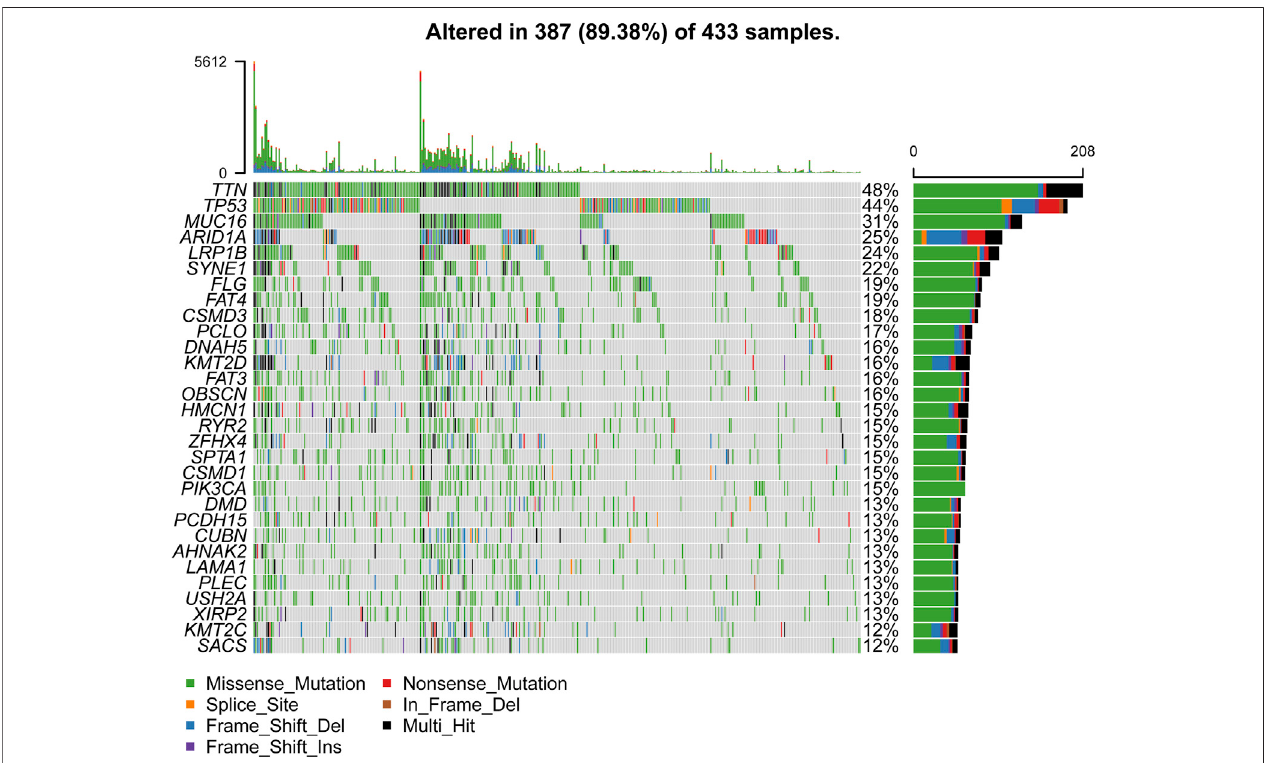
FIGURE 2 | The waterfall diagram of STAD